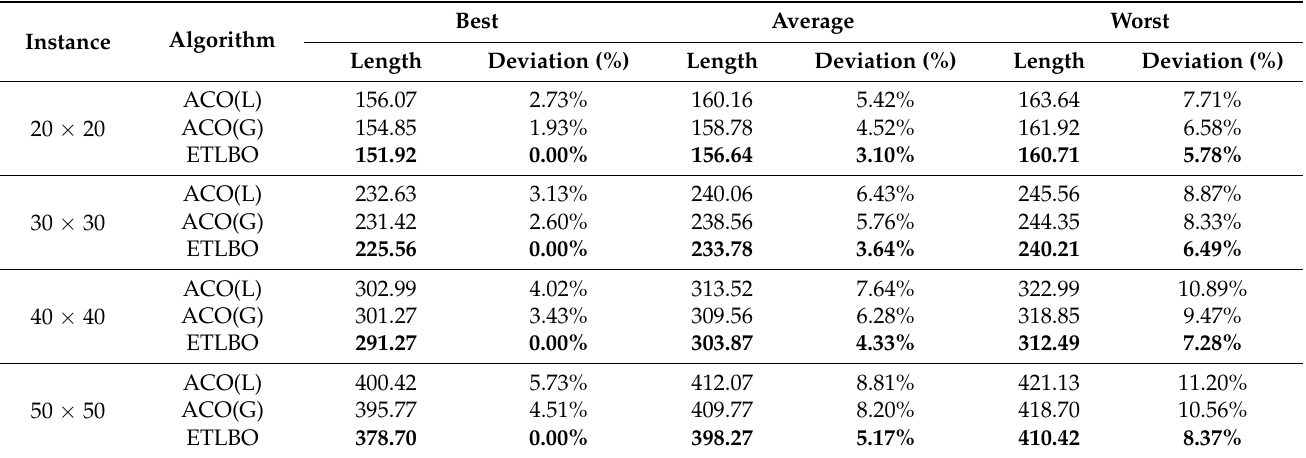
Table 6. Simulation results for MRPP